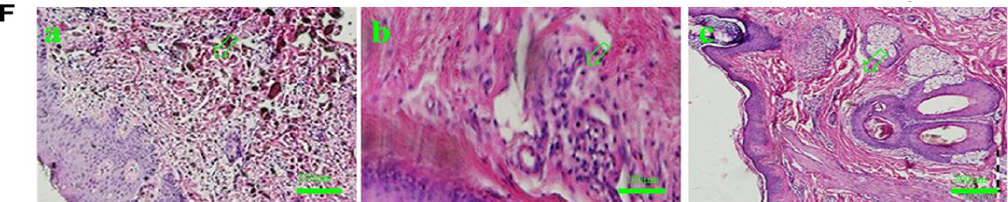
Figure 8. Design and development of dual-drugs loaded electrospun gelatin-based nanofiber mats for wound treatment. ( A ) Schematic illustration of the construction and working mechanisms of novel electrospinning double-layered PCL/gelatin nanofiber dressing. The above layer and bottom layer were made from amoxicillin loaded PCL/gelatin nanofibers and ZnO nanoparticles loaded PCL/gelatin nanofibers, respectively. ( B ) Cumulative release curves of quercetin and ciprofloxacin hydrochloride loaded electrospun PCL/gelatin nanofiber mats. ( C ) Cumulative release curves of EGCG from two different carriers. PGEB: EGCG directedly loaded PLCL/gelatin nanofiber mats; PGEC: EGCG-PLCL/gelatin core-sheath nanofiber mats. ( D ) Cumulative release curves of curcumin from three different carriers. NCs/Cur: curcumin loaded CS nanoparticles; PCL/Gela/Cur: curcumin loaded PCL/gelatin nanofibers: PCL/Gela/NCs/Cur: curcumin loaded CS nanoparticles were further encapsulated into PCL/gelatin nanofibers. ( E ) Regeneration of rabbit wound by using human urine-derived stem cells (hUSCs)-seeded electrospun PCL/gelatin nanofiber dressings. Ctrl: Untreated control group; PCL-GT: PCL/gelatin nanofiber dressing; USCs-PCL-GT: hUSCs-seeded PCL/gelatin nanofiber dressing. ( a ) Actual photographs of wound sites on day 0 and day 14. Statistical analysis for ( b ) wound closure ratio and ( c ) collagen area ratio on day 14. * p < 0.05, *** p < 0.01. ( F ) HE stained images from the wound sites treated with human placenta-derived mesenchymal stem cells (hPDMSCs)-carried electrospun gelatin nanofiber mats containing platelet- rich plasma (PRP). ( a ) Before treatment. ( b ) After two weeks of treatment. ( c ) After six weeks of treatment. ( A ) Reprinted with permission from ref. [165], Elsevier, 2020. ( B ) Reprinted with permission from ref. [166], Elsevier, 2019. ( C ) Reprinted with permission from ref. [168], Elsevier, 2022. ( D ) Reprinted with permission from ref. [169], Elsevier, 2020. ( E ) Reprinted with permission from ref. [170], Springer Nature, 2014. ( F ) Reprinted with permission from ref. [171], Elsevier,